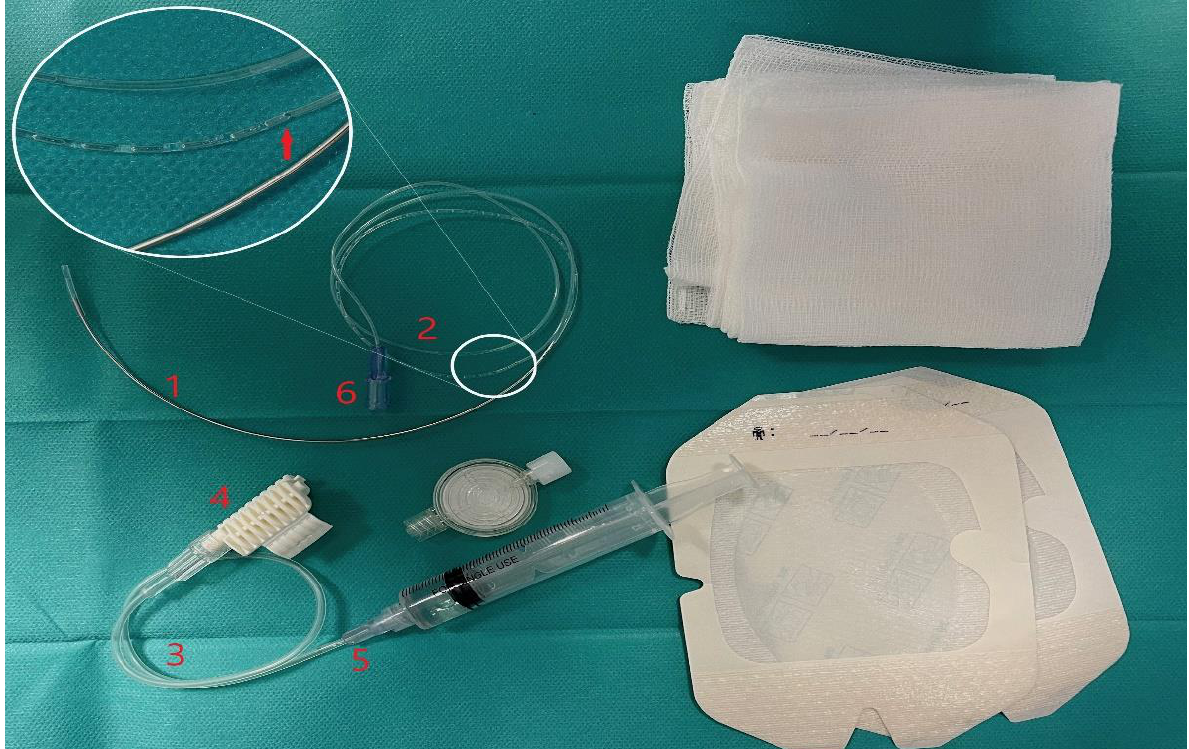
Figure 6. SMC set. SMC set with a suture needle, curvature radius of 5 cm. The catheter is attached to the surgical curved needle. The syringe is attached to the suture-needle with an extension tube. After it has been advanced all the way through the tissues, the needle is detached from the catheter. The solution is administered through two independent ports: the port for the needle and the port for the catheter. The catheter orifices are located in the central part of the catheter. Key: 1—needle; 2—catheter; 3—extension tube; 4—hub; 5—injection port via the needle; 6—injection port via the catheter. Magnification: the arrow indicates the catheter orifices .